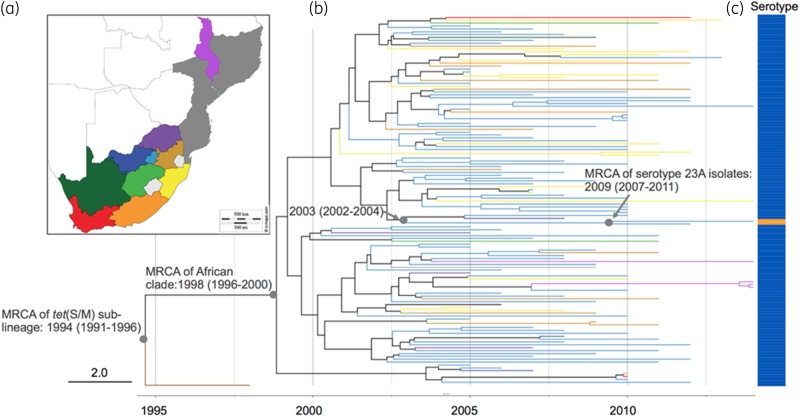
(a) Malawi, Mozambique and administration regions of South Africa. (b) Timed phylogeny for S. pneumoniae tet(S/M) CC230 sublineage (n=129) reconstructed using BEAST. Tree branches are coloured according to the geographical locations in (a), except for the branch for an isolate collected from the USA, coloured in brown. (c) Vaccine serotype 14 is indicated in blue, whereas non-vaccine serotype 23A is indicated in orange.